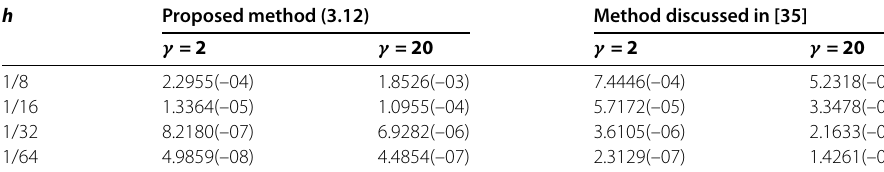
Table 5 Problem 6.4: The maximum absolute